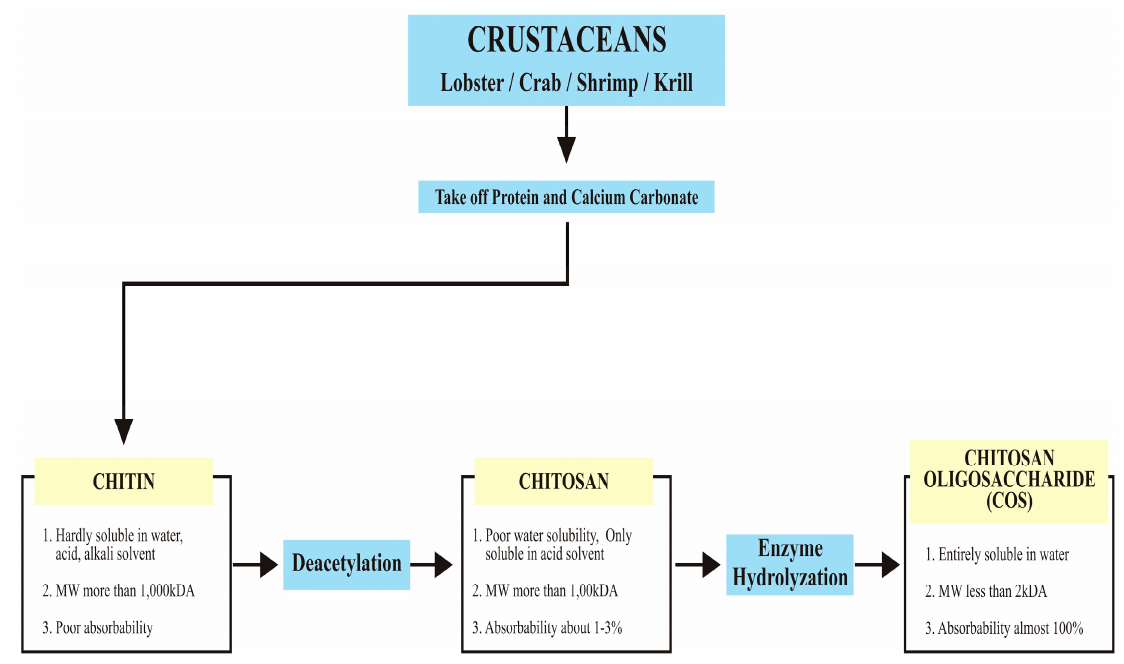
Figure 1. Schematic presentation of deacetylation of chitin derived from crustacean exoskeletons.